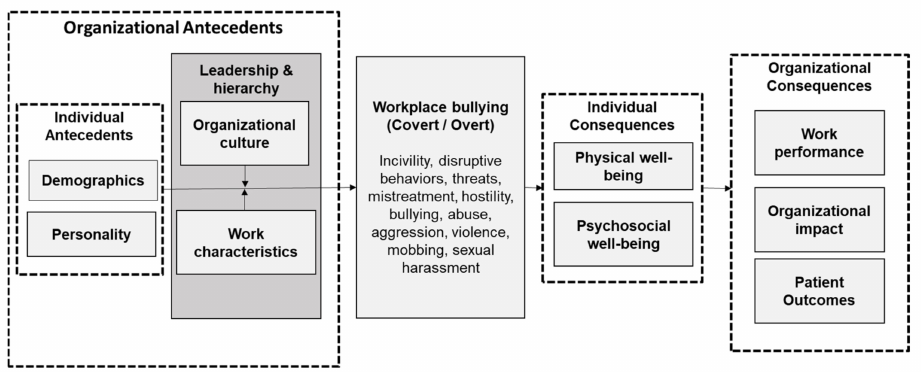
Figure 2. Conceptual Framework for Workplace Bullying among